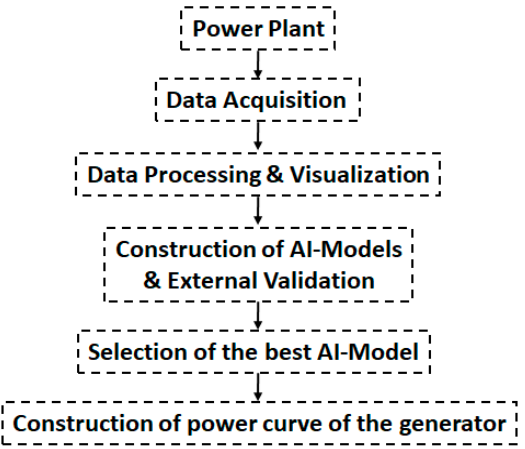
Figure 2. Framework for constructing the data-driven power curve of the generator.